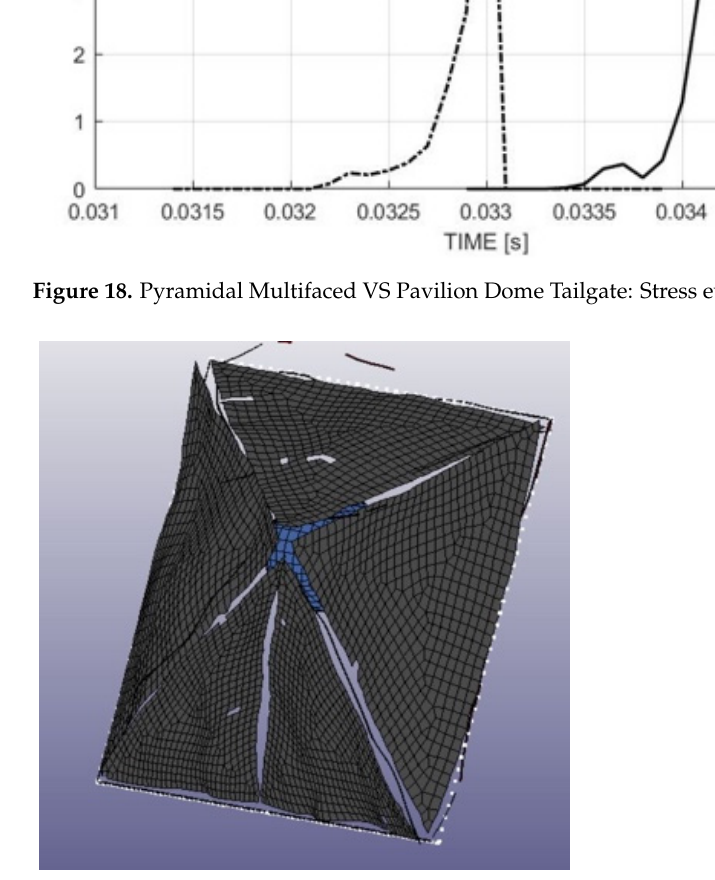
Figure 19. Simulation of Dome Tailgate’s fragmentation after impact.